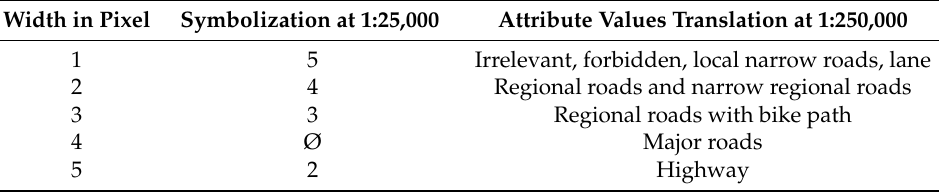
Table 1. Conversion table for width